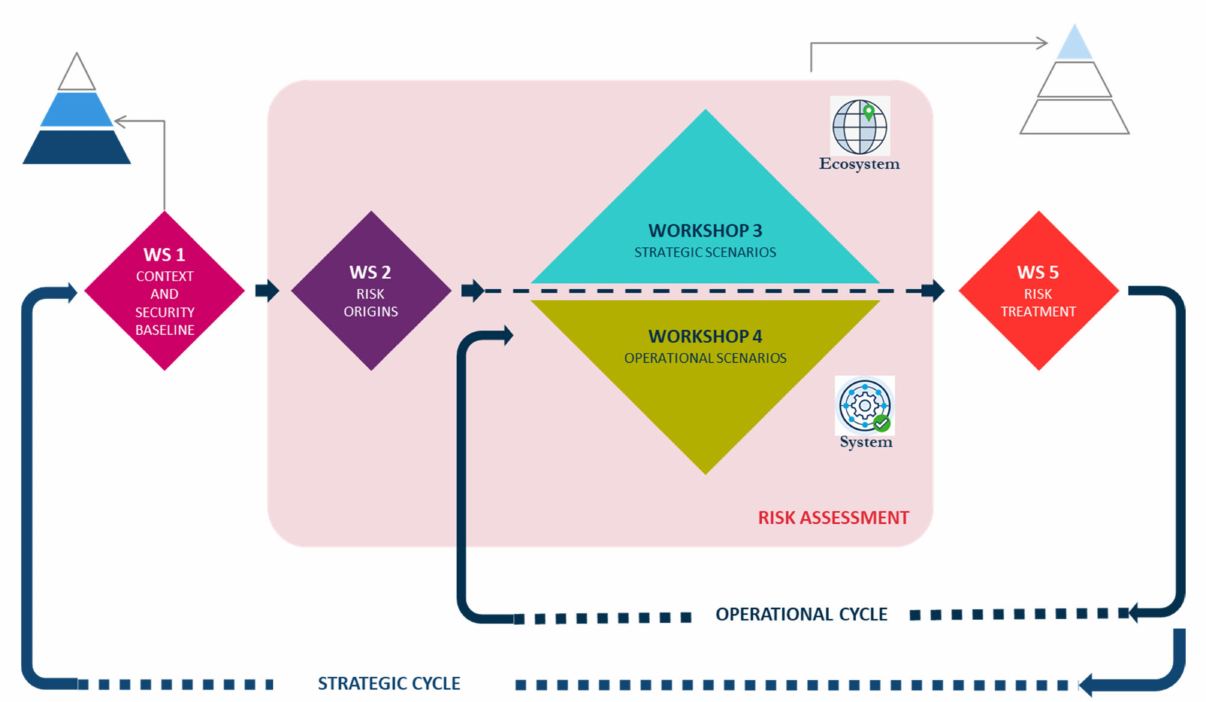
Figure A1. The five workshops of the EBIOS Risk Manager